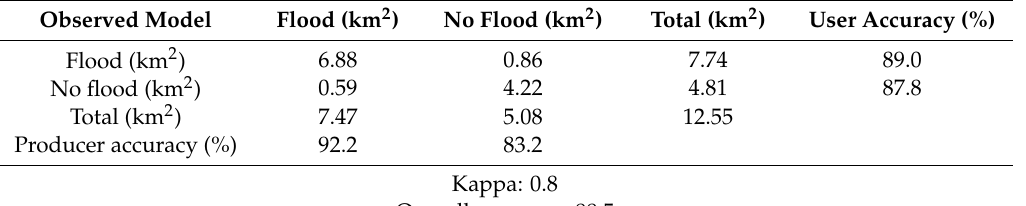
Table 4. Comparison of results from flood map model and official flood map.